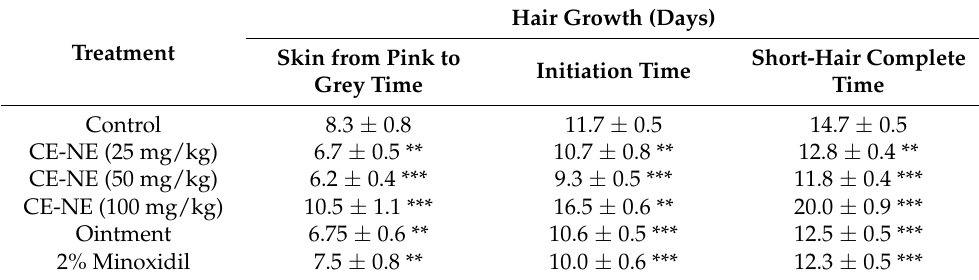
Table 3. Effect of cedrol on qualitative hair growth.